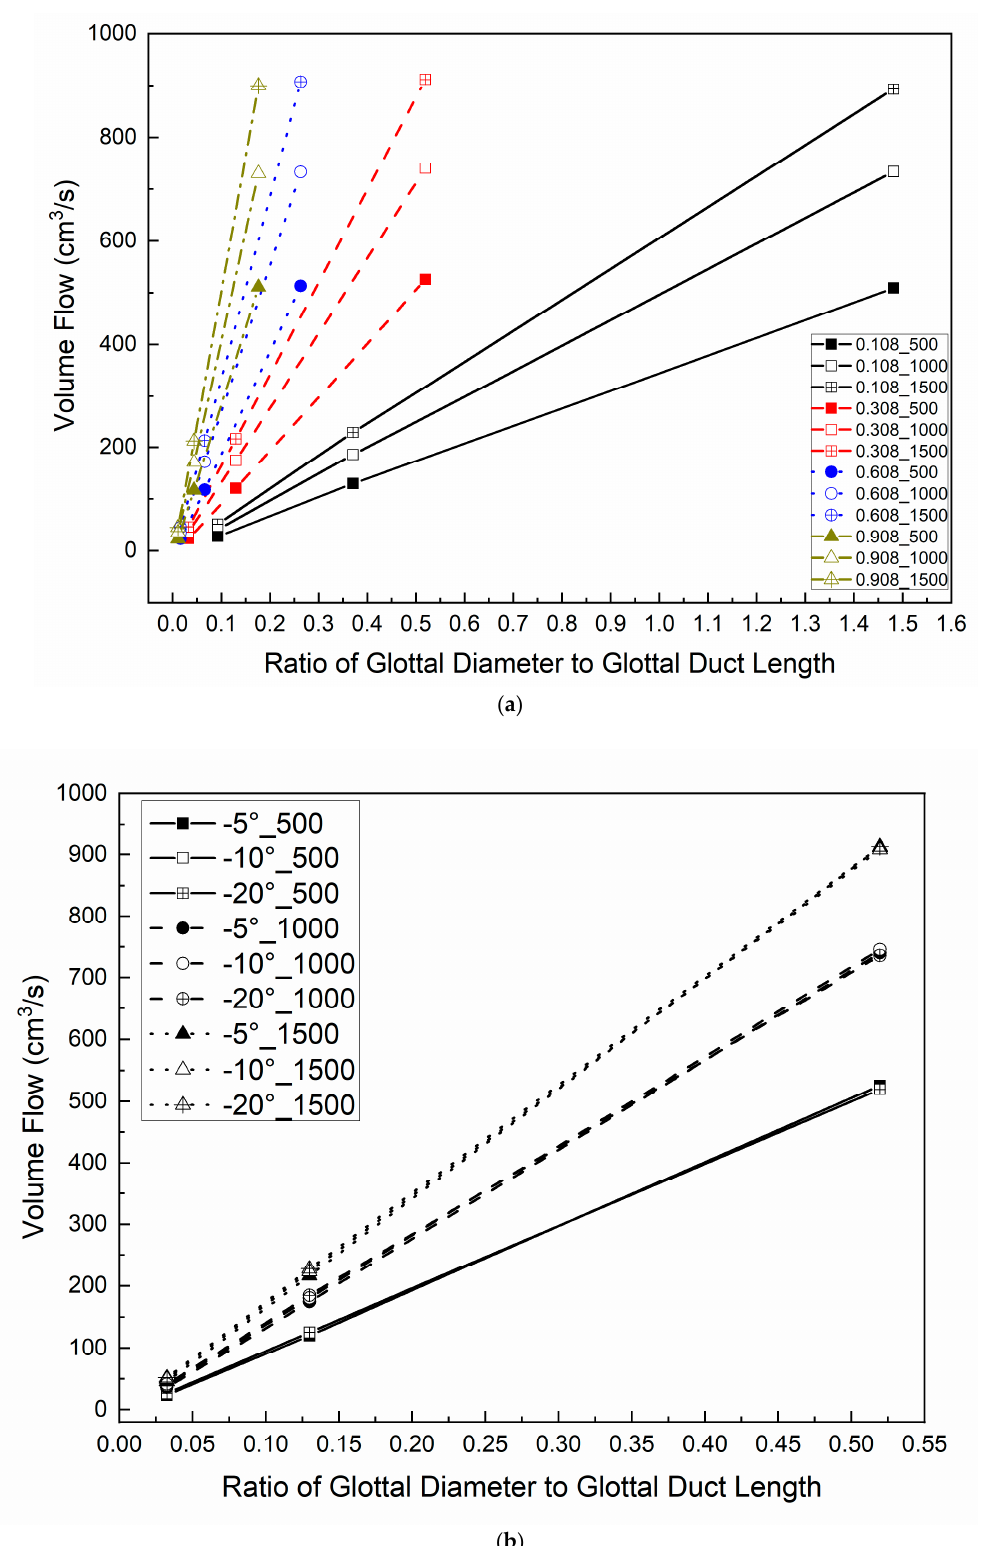
Figure 7. (Color online) Glottal volume flow as a function of the ratio of minimal glottal diameter to the vertical glottal duct length ( a ) for 0.108cm, 0.308cm, 0.608 cm, and 0.908 cm vertical glottal duct length, 500 Pa, 1000 Pa, and 1500 Pa transglottal pressure for − 5 ◦ convergent glottal angle; ( b ) for − 5 ◦ , − 10 ◦ , and − 20 ◦ convergent glottal angles for 500 Pa, 1000 Pa, and 1500 Pa transglottal pressures only for 0.308 glottal duct length